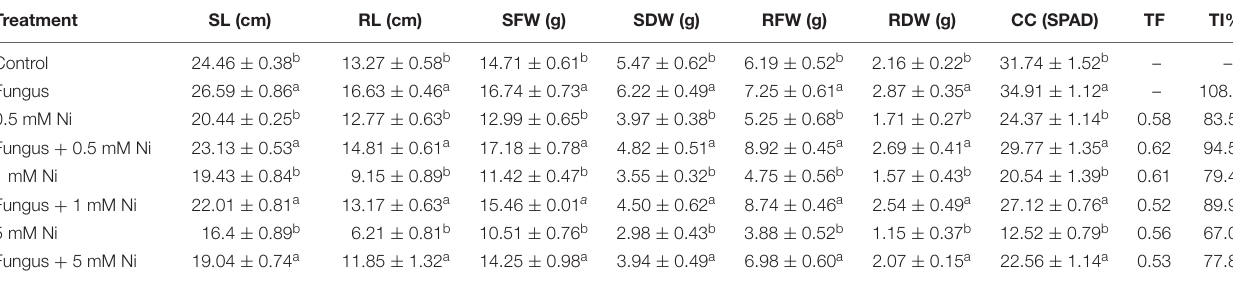
FIGURE 2 | Effect of endophytic fungus on plant growth under Ni stress. Each plant represents 15 replicates of eight treatments. TABLE 2 | Growth promoting effect of Paecilomyces formosus LHL10 in soybean under various nickel stress.